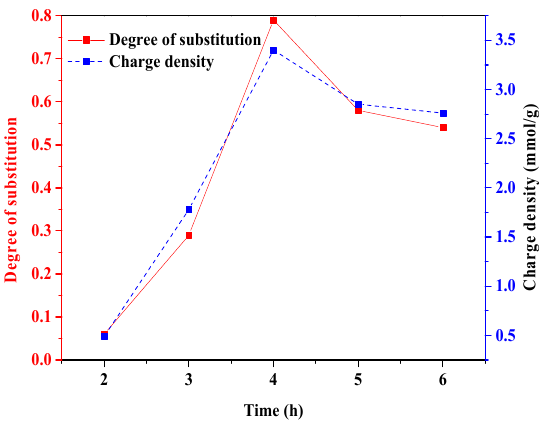
Figure 5. The effect of time on the degree of substitution and charge density of phosphorylated xylan (conducted at the xylan/STMP molar ratio of 1/3 and 80 °C).